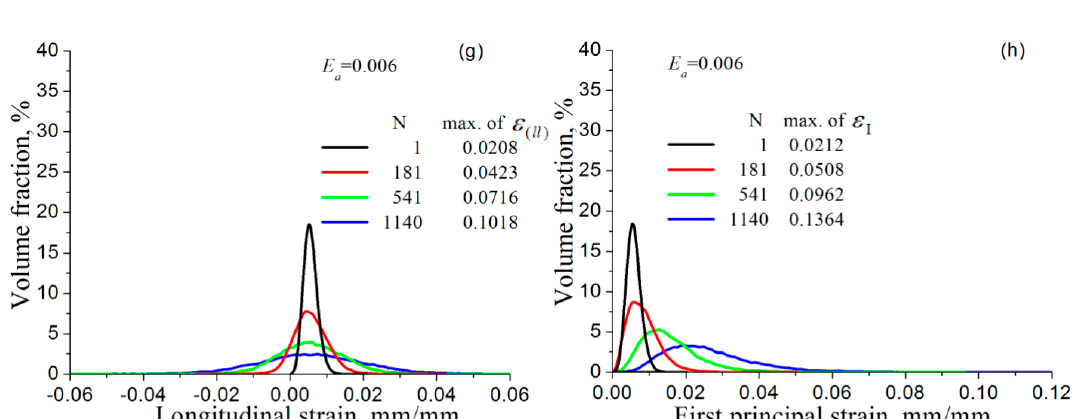
ε ε Figure 4. Distribution of the longitudinal strain ε ( ll ) ( a , c , e , g ) and the first principal strain ε 1 ( b , d , f , h ) in Figure 4. Distribution of the longitudinal strain ( ) ll ( a , c , e , g ) and the first principal strain 1 pure copper at the tensile peaks of different cycles for various strain ( b , d , f , h ) in pure copper at the tensile peaks of different cycles for various strain amplitudes.